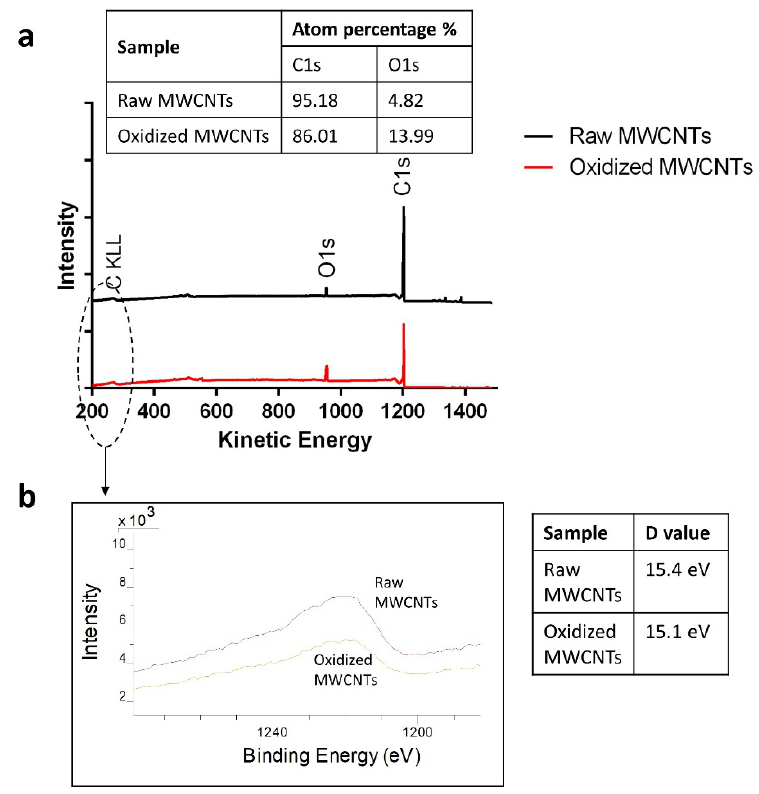
Figure 2. XPS analysis of ( a ) complete spectra of raw and oxidized MWCNTs and ( b ) the auger region and parameter D values.